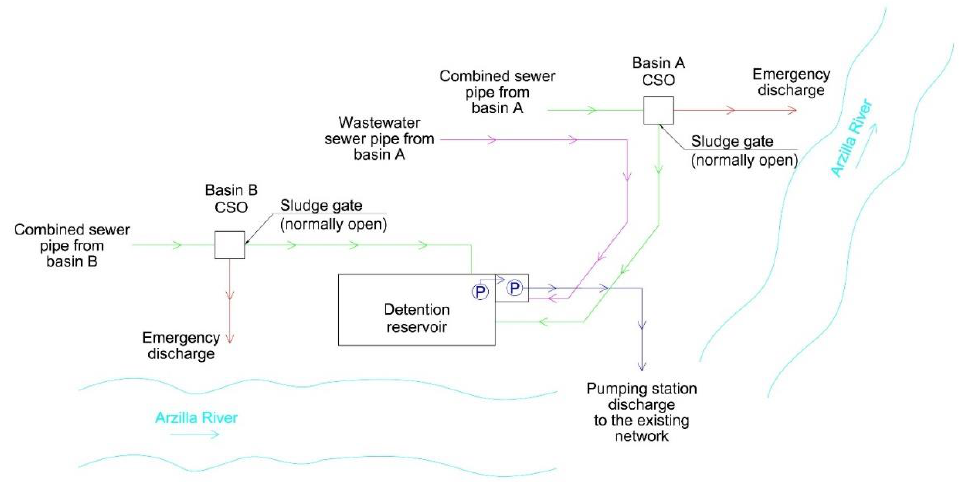
Figure 5. Operation scheme of the detention